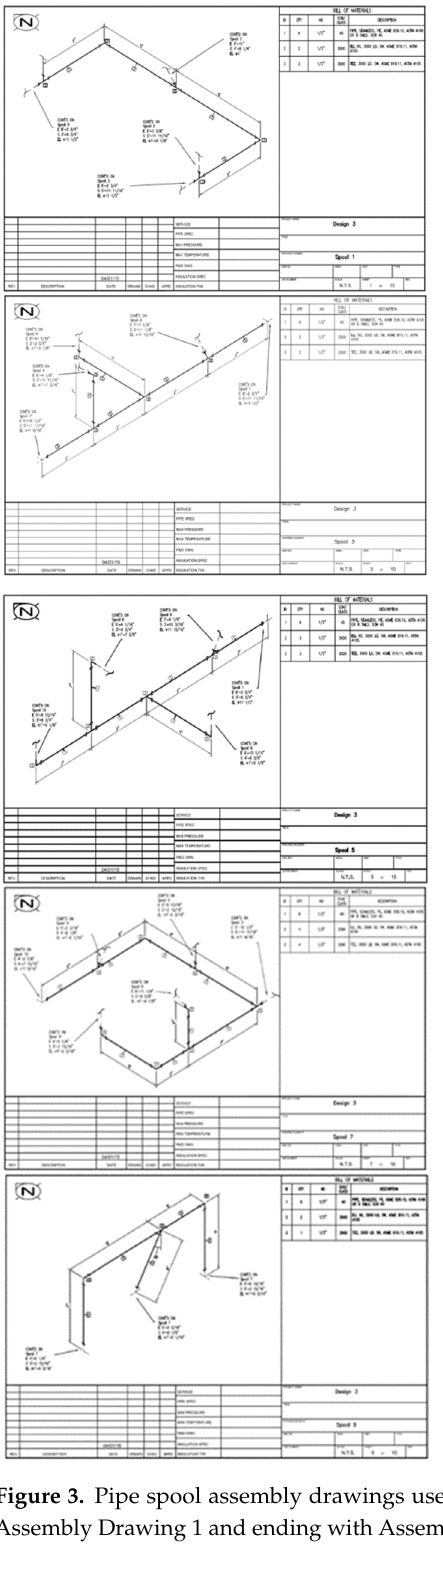
Figure 2. Completed pipe spool assembly model.